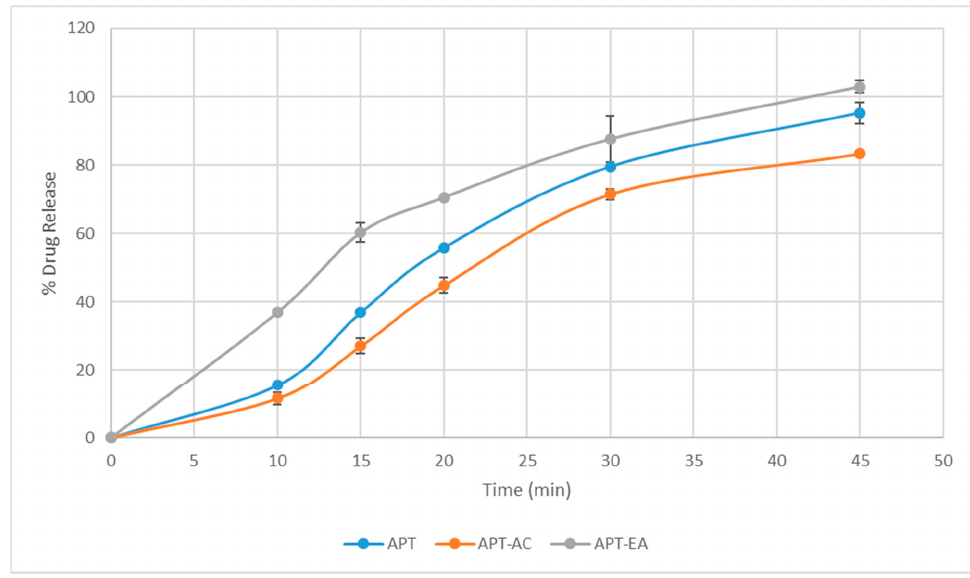
Figure 10. Dissolution profile. All values were calculated as mean ± SD, n =